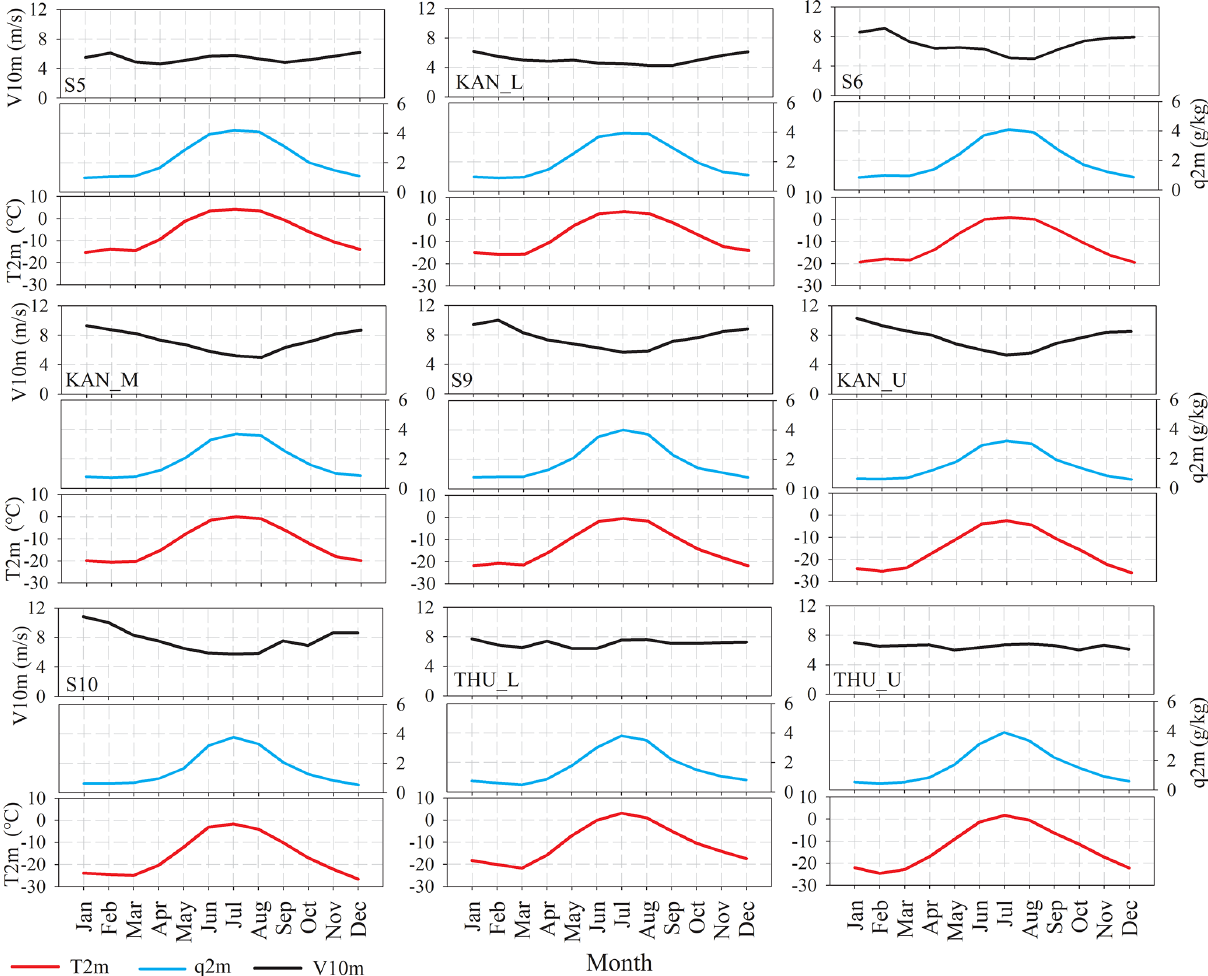
Figure 8. Multiyear average seasonal cycle based on monthly means of 2m temperature (red, T 2m ) , specific humidity (blue, q 2m ) calculated from relative humidity and wind speed at 10m (black, V 10m